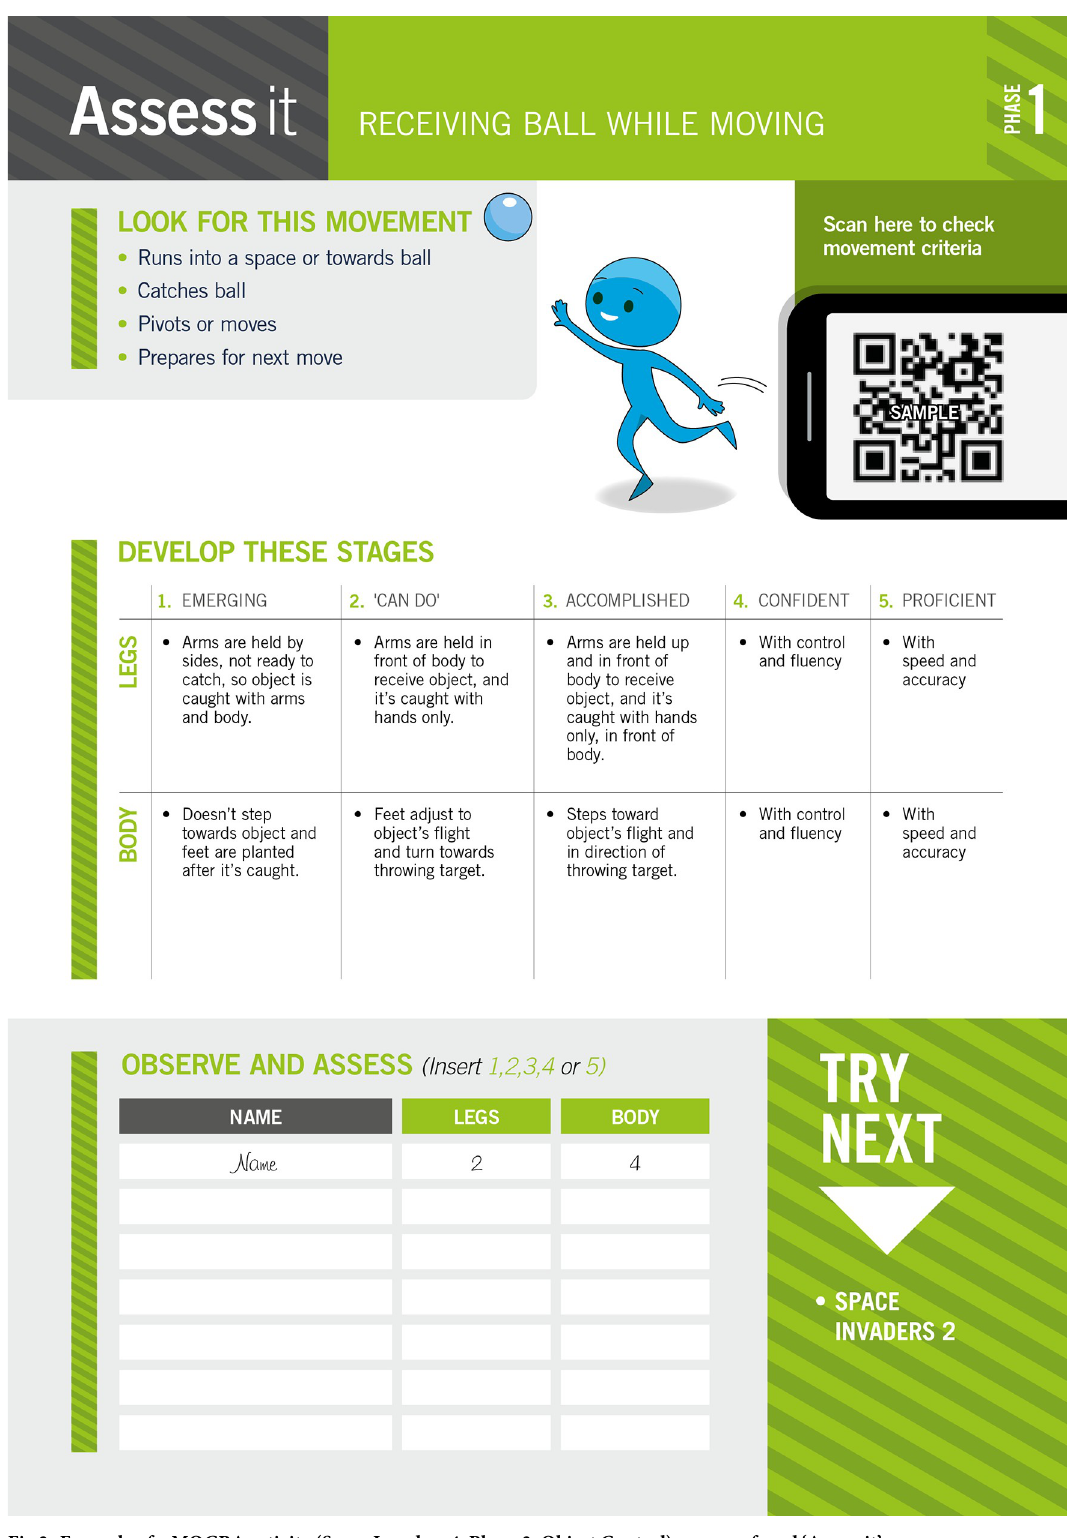
Fig 2. Example of a MOGBA activity (Space Invaders 4, Phase 3, Object Control) reverse of card ‘Assess it’.